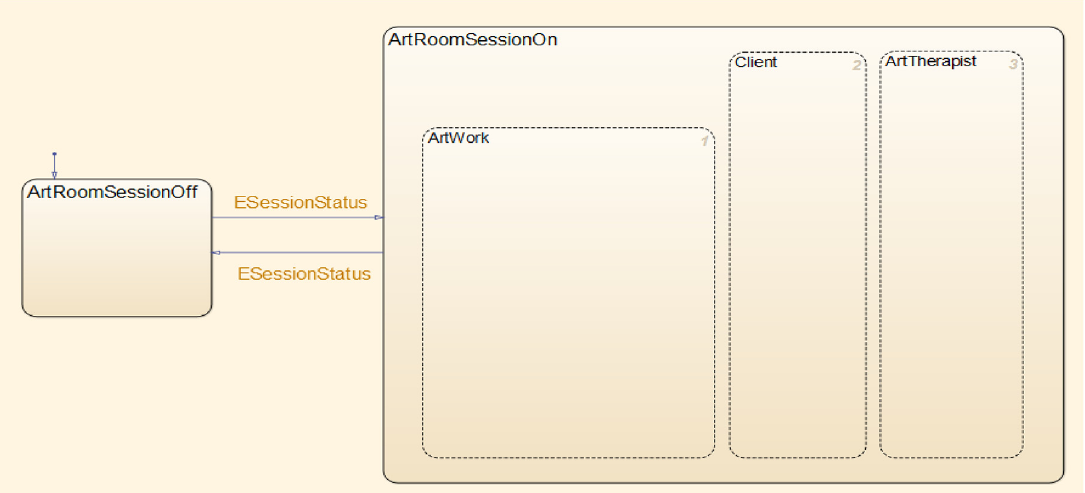
Fig 2. The top-level model of the system. The Statecharts visual formalism [46] exemplified in modeling the high-level state of the art room and three concurrent/orthogonal states (dashed lines) specifying the entities therein: the Artwork , Client (patient) and ArtTherapist . The figure also shows the events that trigger the beginning of the therapy session and its termination, specified as mutually exclusive states, ArtRoomSessionOn and ArtRoomSessionOff , respectively (with solid